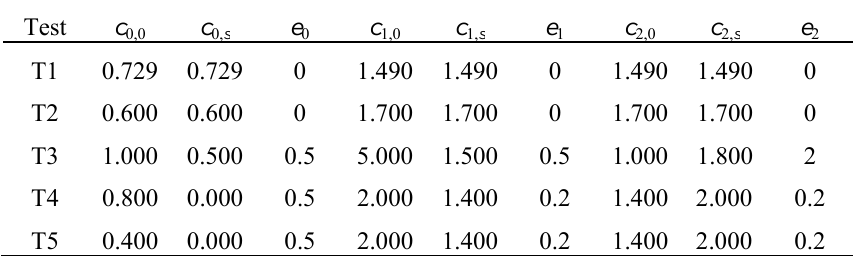
, c , c in the tests. 0 1 2